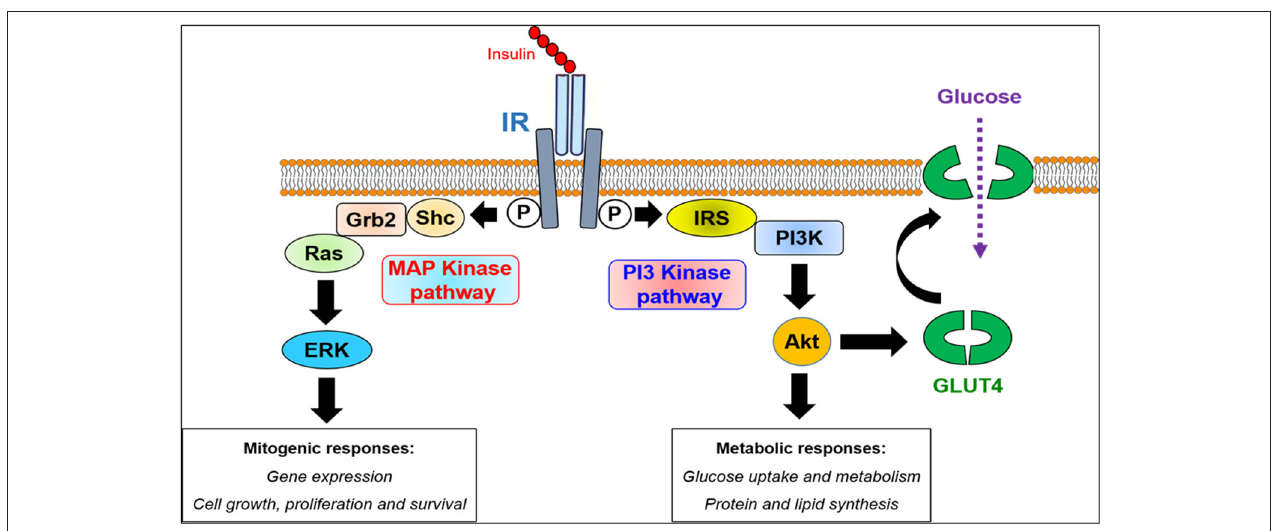
FIGURE 4 | Intracellular insulin receptor signaling. The binding of insulin to its cell surface receptor (IR) in the major target tissues results in receptor activation associated with its phosphorylation (P) at tyrosine residues in the cytoplasmic domain of IR. This constitutes the signal for the recruitment of various cytoplasmic scaffolding and signaling proteins plausibly controlling two major downstream signaling pathways, the PI3-kinase and the MAP kinase pathways. The PI3-kinase pathway mediates the metabolic responses of insulin through the activation of the canonical kinase AKT controlling the expression and the translocation of the glucose transporter GLUT4 thereby glucose uptake as well as the metabolism of proteins and lipids. However, the MAP kinase pathway triggers the mitogenic responses of insulin via the activation of the canonical Ras/Raf/ERK1/2 cascade controlling the expression of genes involved in cell proliferation and growth.